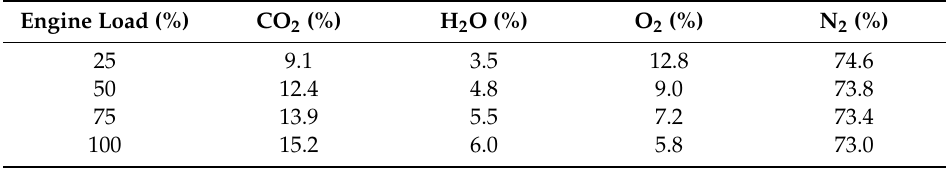
Table 2. Composition of exhaust gases for the diesel